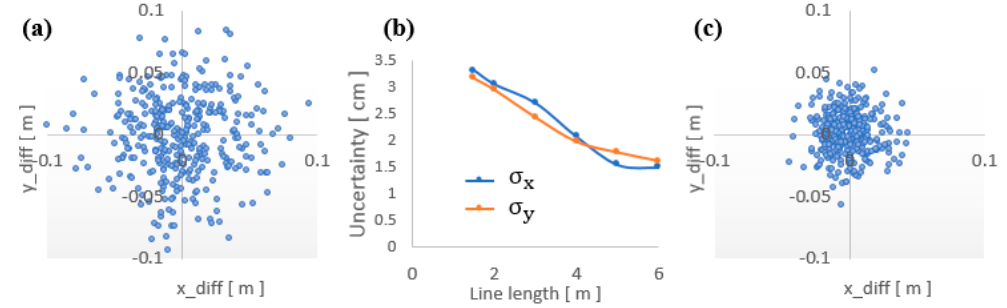
Figure 12. The point location uncertainty using airborne lidar simulator.